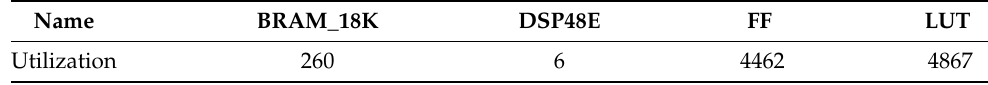
Table 1. Hardware scheduler resources